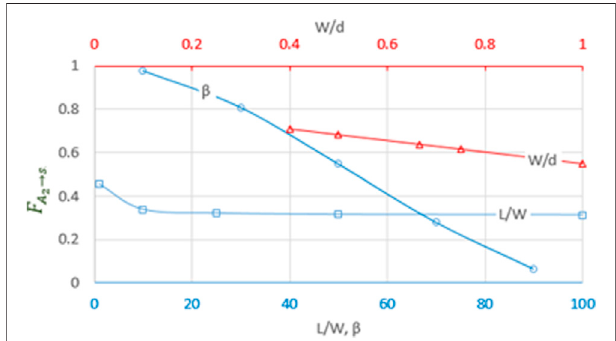
FIGURE 9 | In fl uence of solar fi eld design parameters on F A